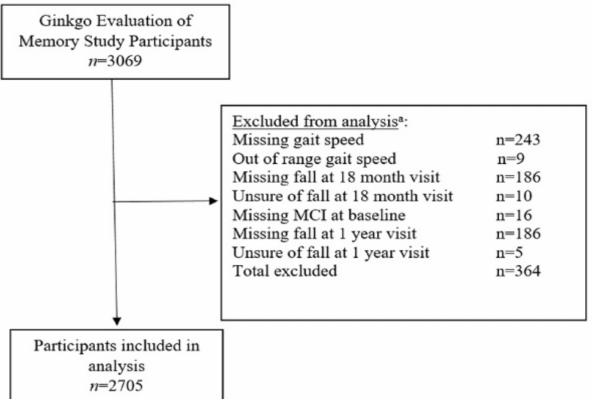
Figure 2. Participants included in analysis. a Categories are not mutually exclusive; some participants were missing data for multiple